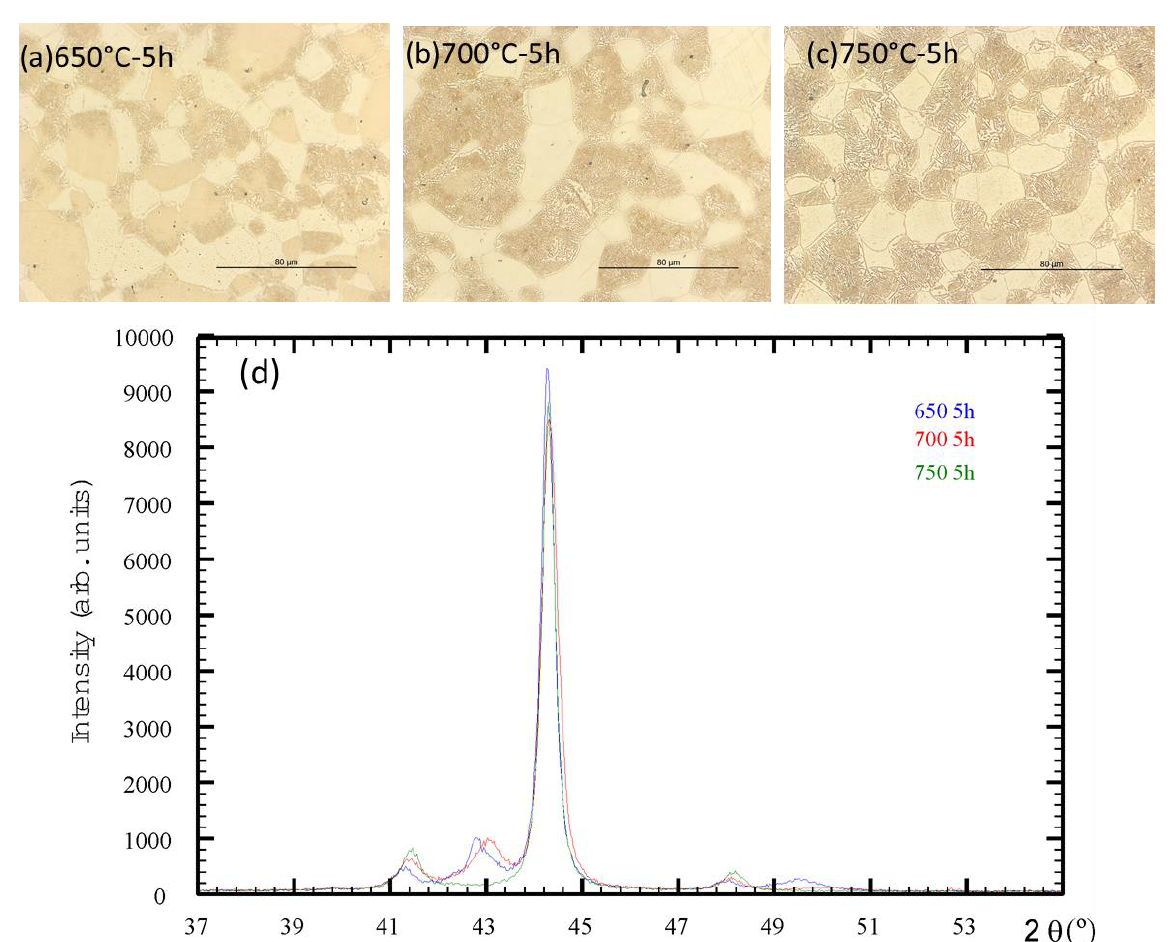
Figure 9. Optical micrographs of the alloy after 5 h of heat treatment at ( a ) 650 °C, ( b ) 700 °C and ( c ) 750 °C. In ( d ), their corresponding diffractograms are shown.